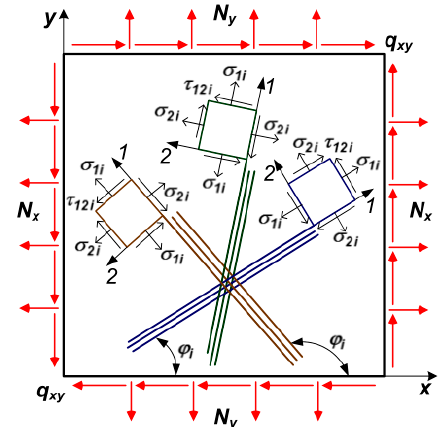
Figure 5. Structure of composite lamina.